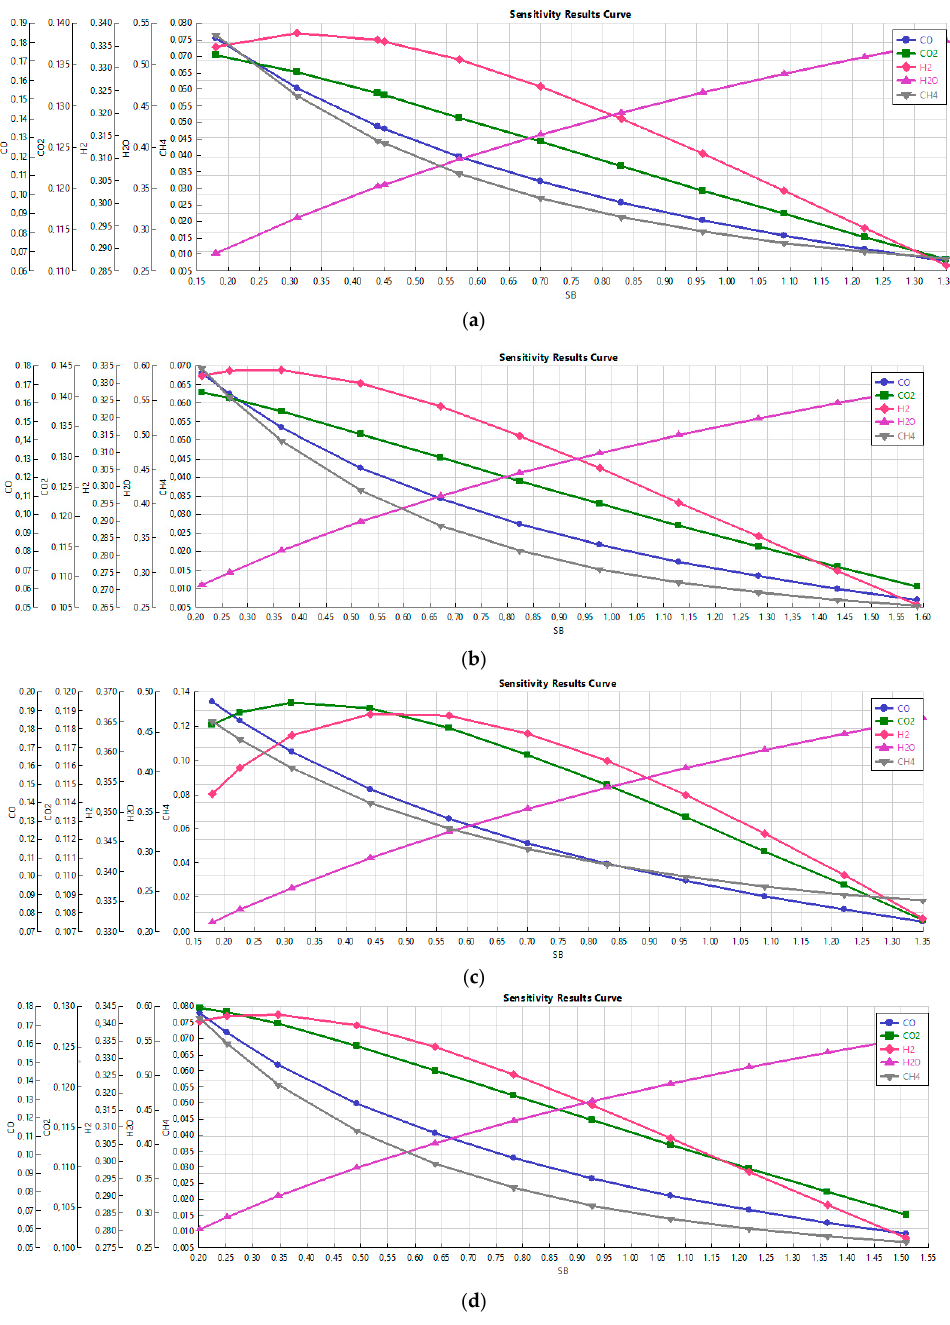
Figure 8. ( a ) Effect of the S/B ratio on the syngas composition from hazelnut shells. ( b ) Effect of the S/B ratio on the syngas composition from olive pruning. ( c ) Effect of the S/B ratio on the syngas composition from pomace olive. ( d ) Effect of the S/B ratio on the syngas composition from wheat straw.